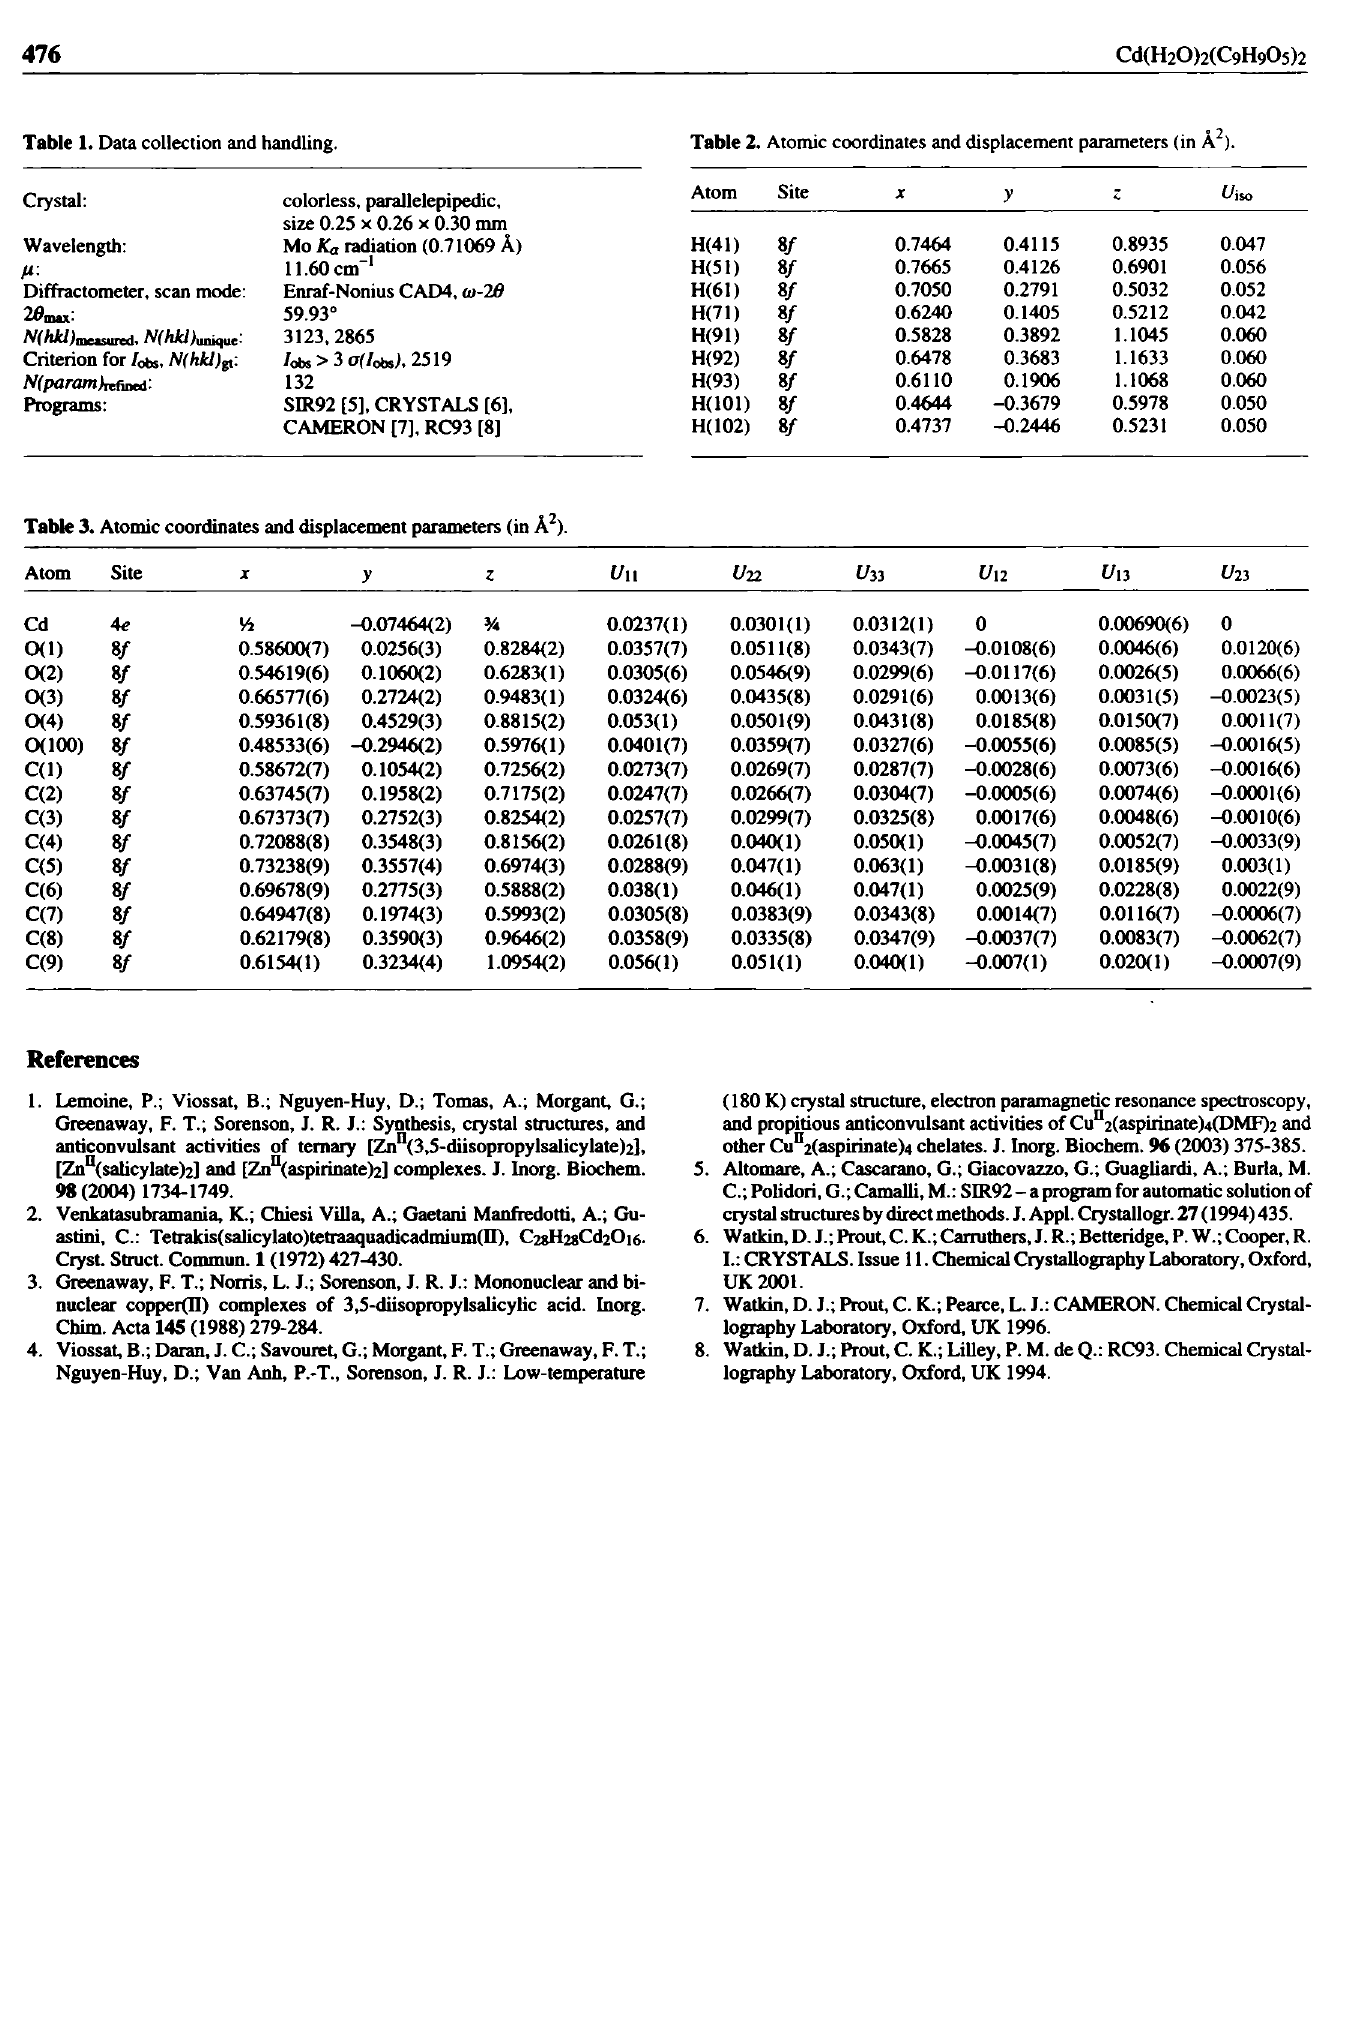
Table 1. Data collection and handling. Table 2. Atomic coordinates and displacement parameters (in A 2 ).